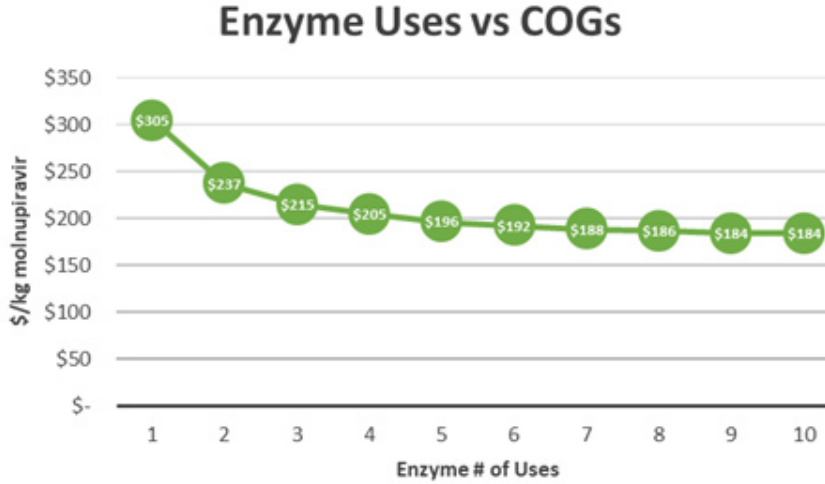
Figure 8. M4ALL Biocatalytic Route B from Cytidine Enzyme usage versus